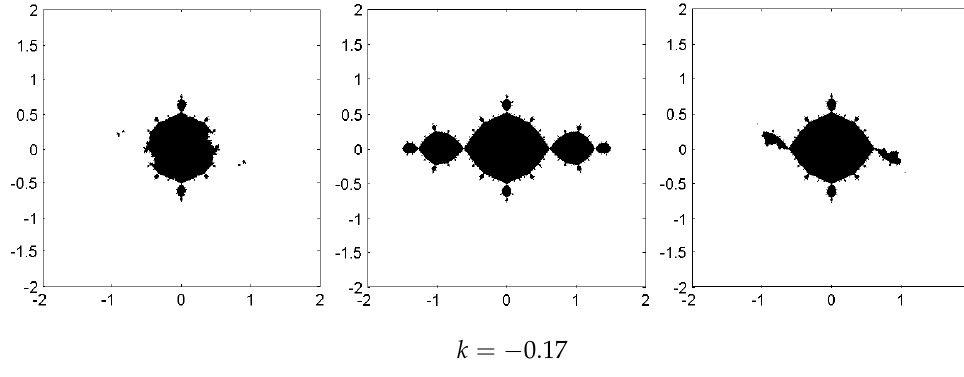
Figure 3. Changing of Julia sets without consensus for the same control parameter.